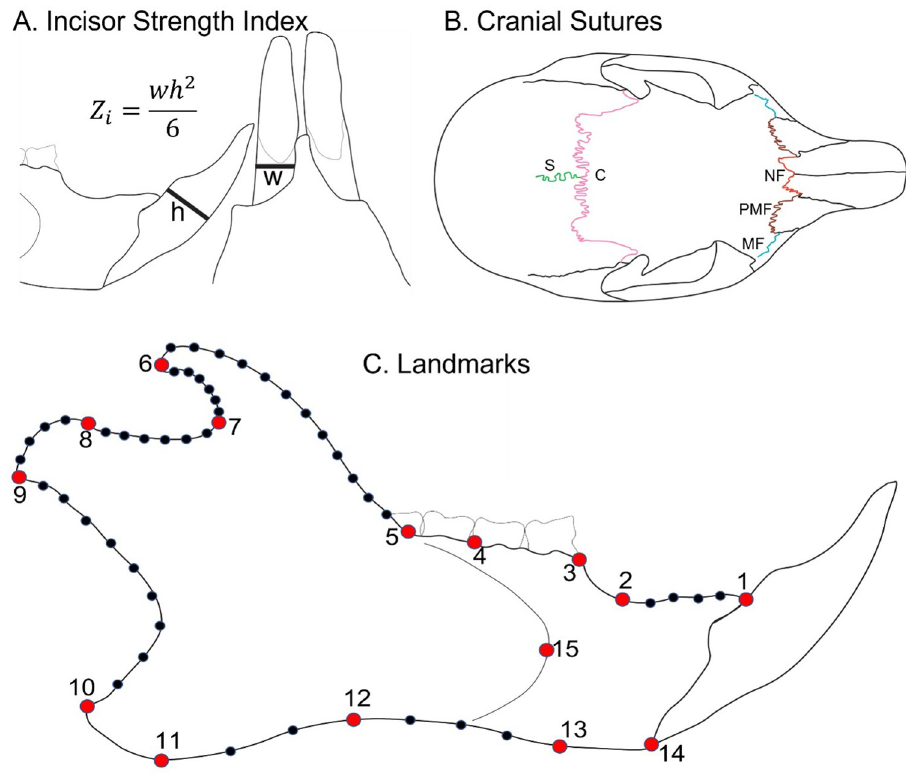
(labeled NF) in red, the premaxillofrontal suture (labeled PMF) in brown, the maxillofrontal suture (labeled MF) in yellow, the coronal suture (labeled C) in pink, and the sagittal suture (S) in green. (C) Position of landmarks (large